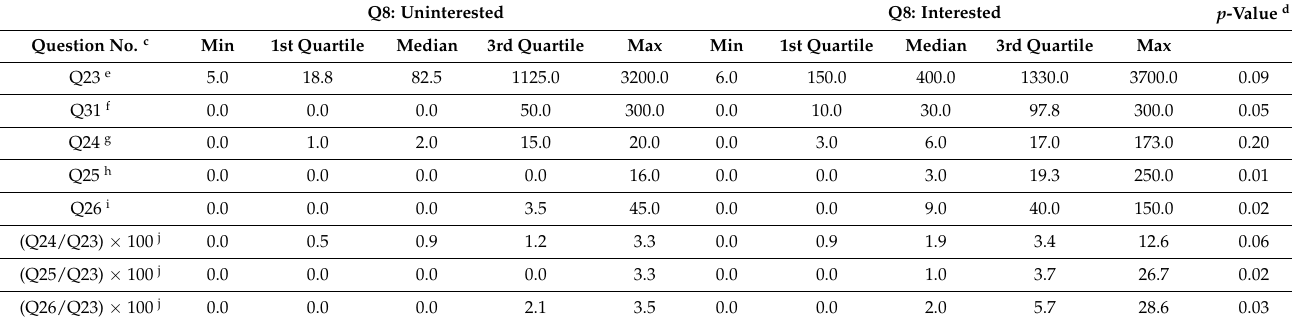
Table 3. Descriptive statistics and the results of univariable analysis of the association between the binary version of the outcome of interest Q8 (Uninterested vs. Interested in adopting culture- based testing for treating mastitis, referenced as “CULTURE-BASED TREATMENTS”) and variables representing the numerical free choice survey questions as well as variables describing the calculated frequency of (i) clinical mastitis and (ii) injectable and (iii) intramammary antibiotic treatment doses per 100 lactating cows a,b